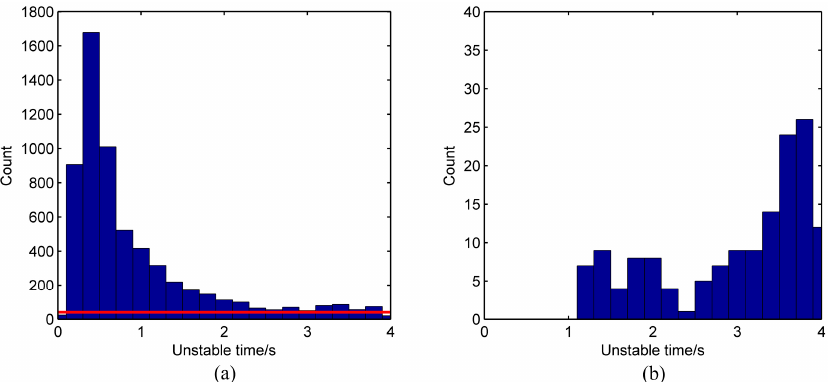
Figure 17. Histogram of unstable time: ( a ) Total testing unstable instances; and ( b ) Uncertain unstable